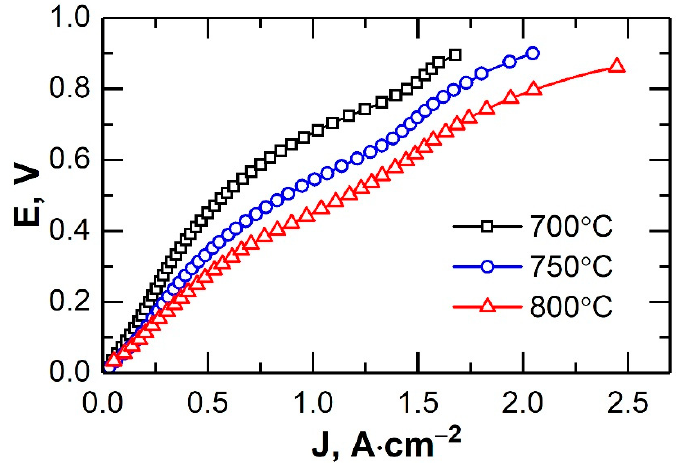
Figure 10. Current–voltage performance of the microtubular oxygen pump.